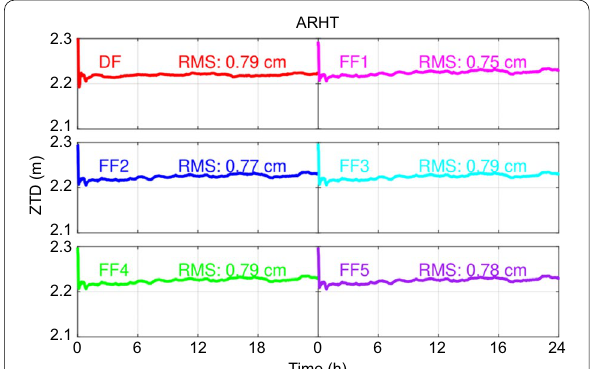
Fig. 10 Estimated ZTD delay time series at station arht with different